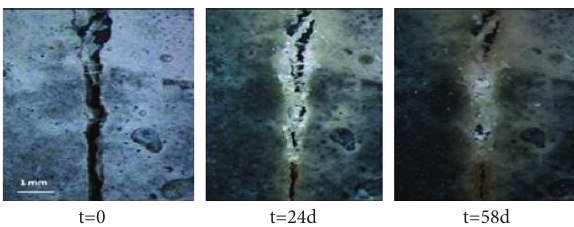
Figure 2: Self-healing of a 0.8 mm wide crack in concrete